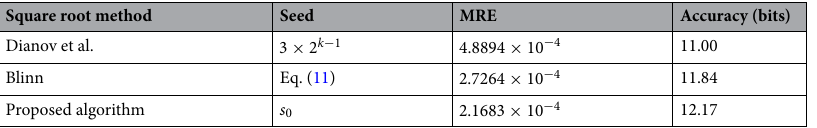
Table 6. The impact of using different seeds on the accuracy results of our proposed algorithm with a LUT size of 1 KB.